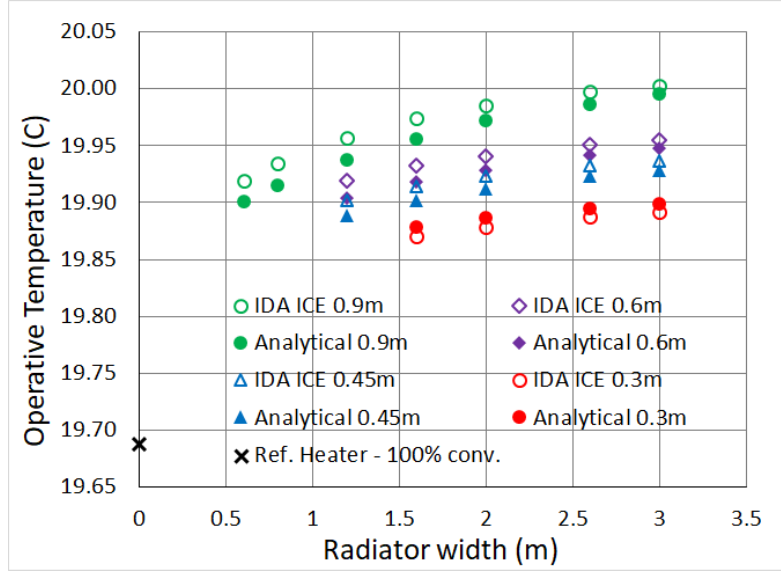
Figure 9. Operative temperatures for a 10-type panel radiator, with h = 0.3, 0.45, 0.6, 0.9